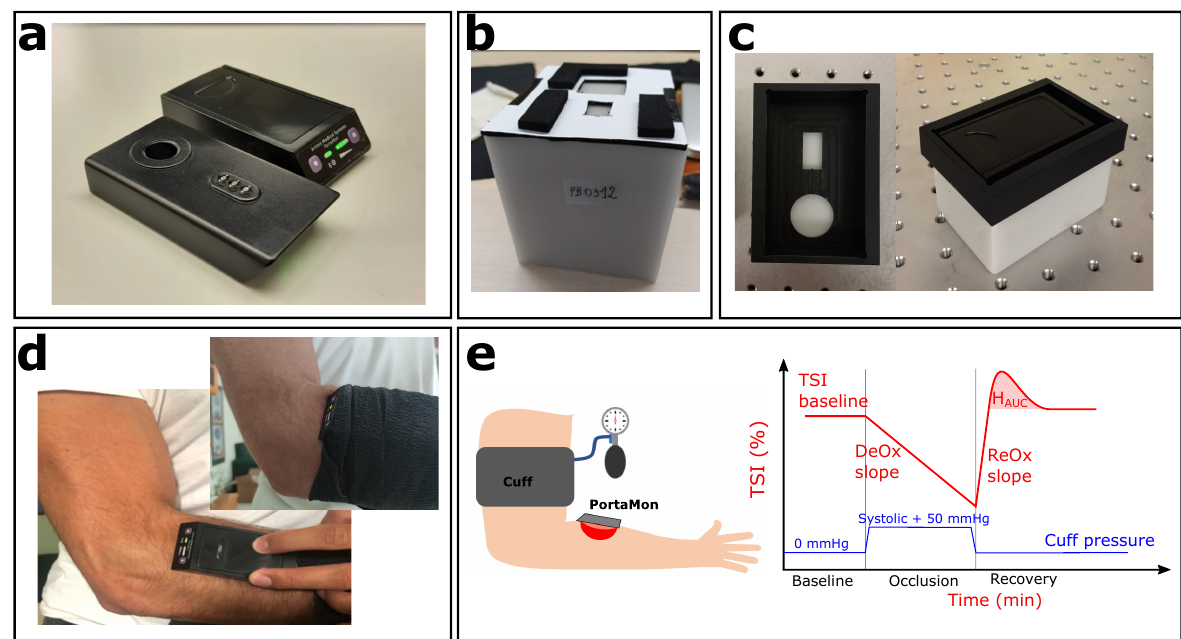
Figure 2. Experimental setup. ( a ) Two PortaMon (Artinis Medical Systems) devices used in this study; top and bottom view. ( b ) Biomimic PB312 phantom, with the custom mask for PortaMon placement. ( c ) One of the BioPixS phantoms, together with the custom mask (left panel, top view) and the PortaMon placed (right panel). ( d ) PortaMon placement for forearm muscle measurements. ( e ) Sketch of the VOT procedure together with a visual representation of the measured relevant